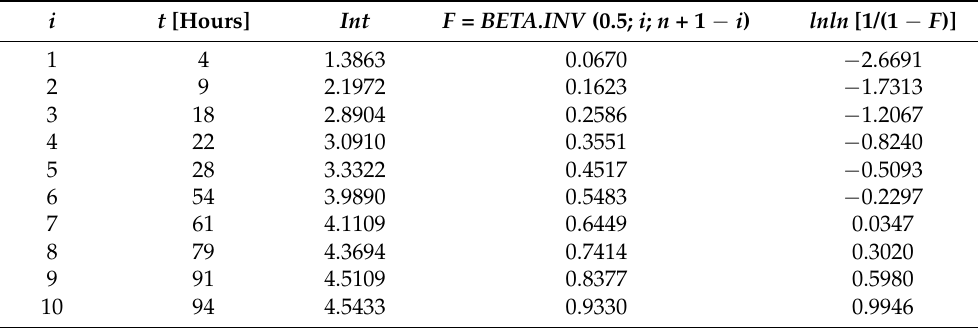
Table 3. Calculated values for estimating and linear regression of the distribution function F ( t ) for γ optimum = 206